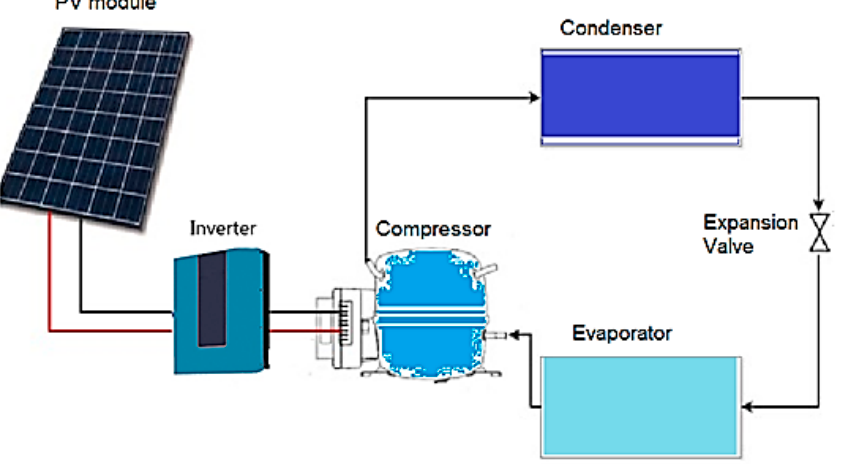
Figure 3. Coupled PV and air conditioning main